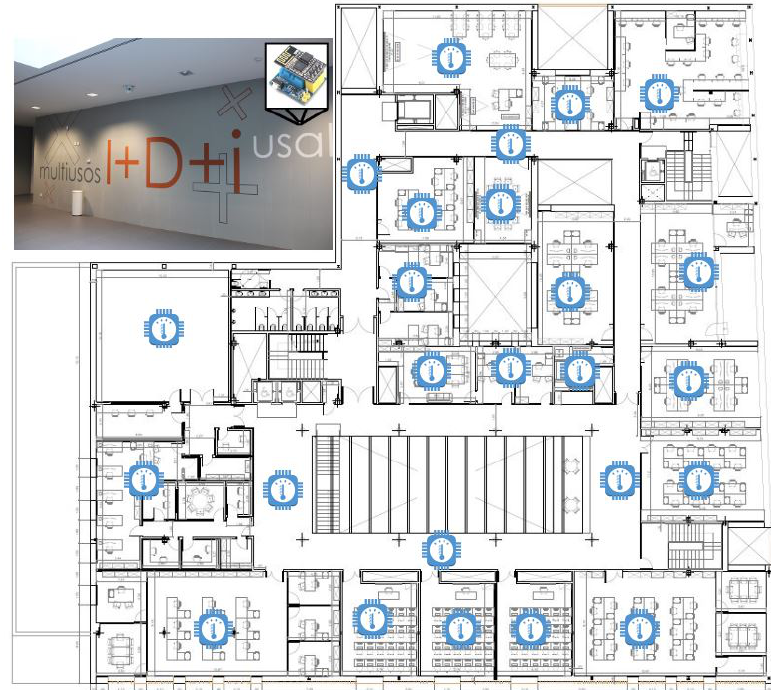
Figure 4. Map of the case study building. In this figure, IoT device location in the smart building is displayed.